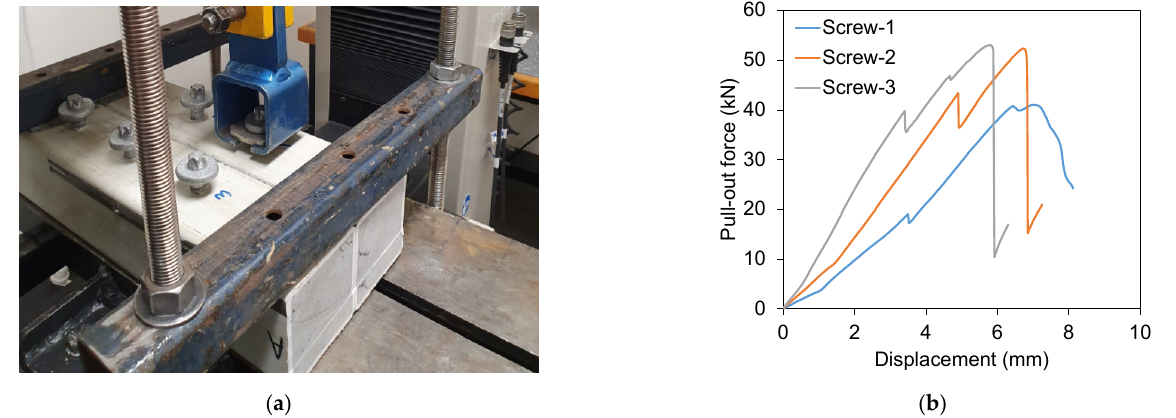
Figure 7. Pull-out test of the PFR core FRP sleeper (Concept-2). ( a ) Pull-out test setup. ( b ) Pull-out force vs displacement.